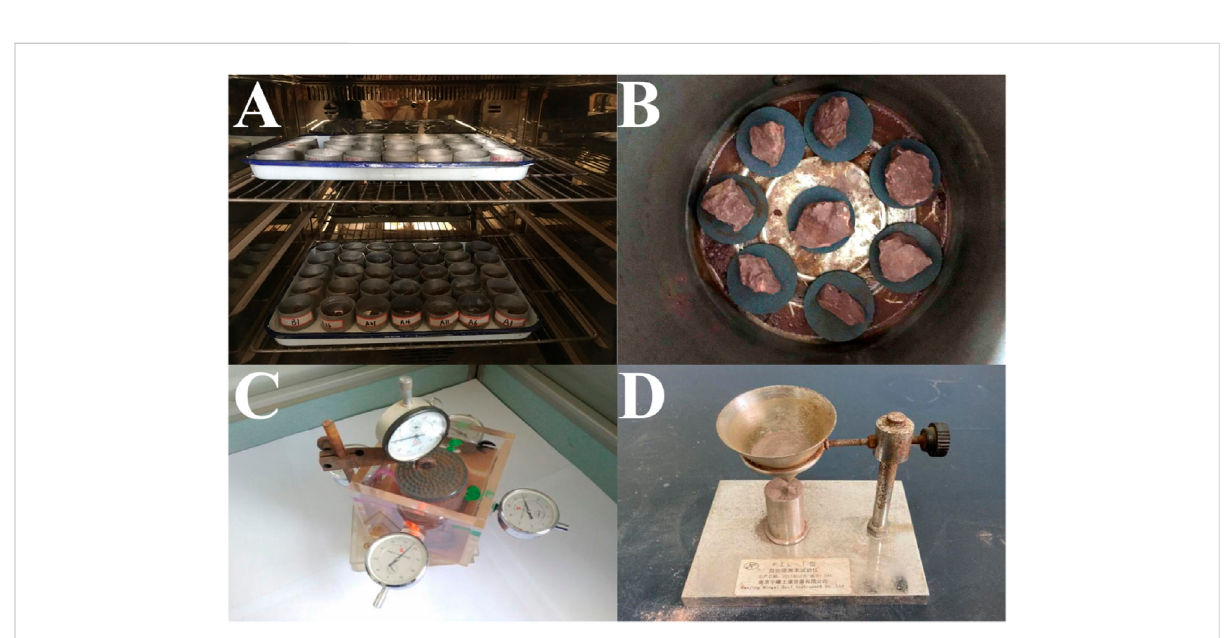
avoid the in fl uence of water on the mechanical properties of mudstone, drilling and polishing were done in anhydrous conditions. In addition, samples with uneven or cracked surfaces were discarded. The remaining samples were